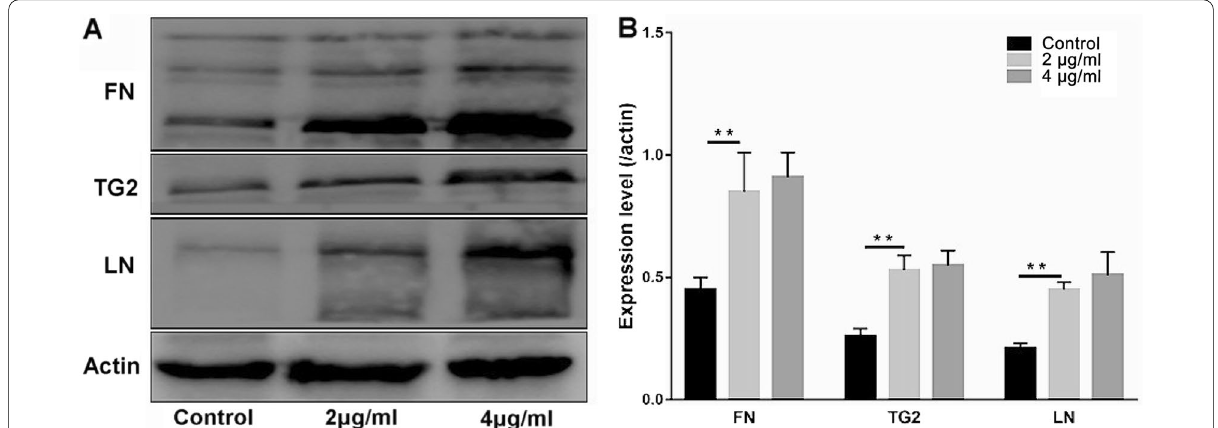
Fig. 7 Transglutaminase 2 (TG2) was involved in the osteogenic differentiation of EMSCs. EMSCs were incubated with BPs (2 and 4 μg/ml) for 14 days, and fibronectin (FN), LN, and TG2 levels were assessed by immunoblotting. Data were expressed as mean